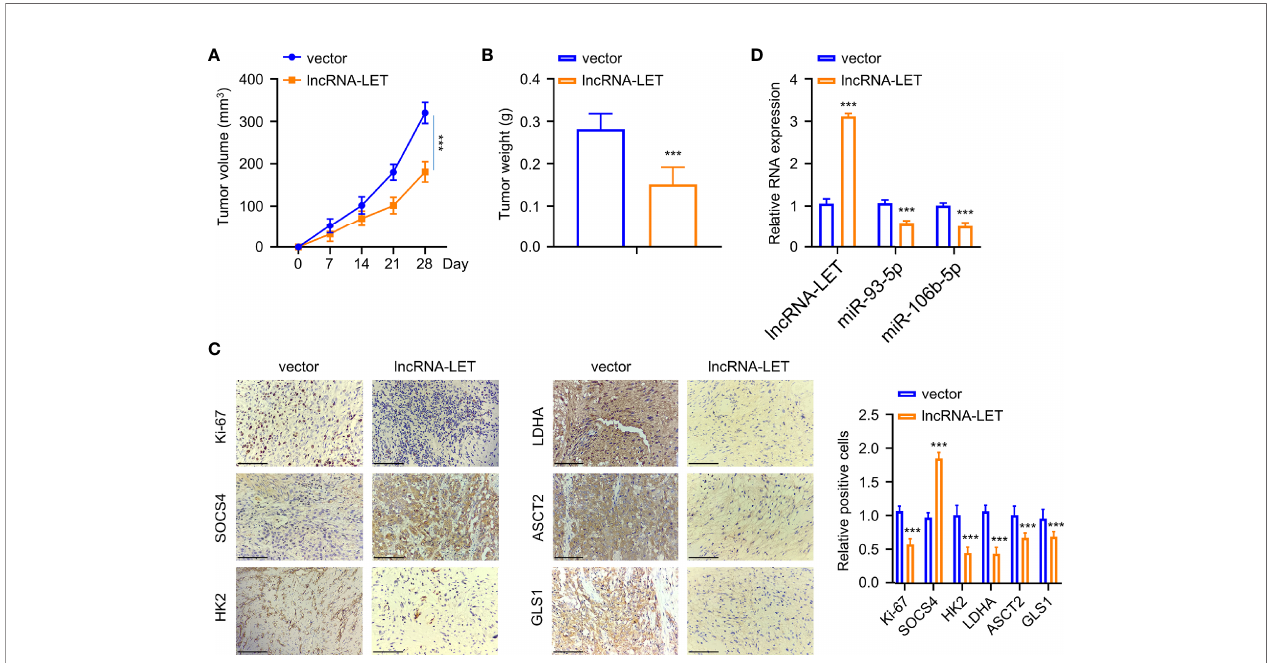
FIGURE 7 | An increase of lncRNA-LET inhibited esophageal squamous cell carcinoma cell proliferation in vivo . (A) The subcutaneous tumor volume in the tumor xenograft model. (B) The tumor weights in different groups. (C) The expression of Ki-67, SOCS4, hK2, ldhA, ASCT2, and gls1 proteins in subcutaneous tumor tissues was detected by immunohistochemistry. (D) lncRNA-LET, miR-106b-5p, and miR-93-5p expression within subcutaneous tumor tissues were detected through qRT-PCR. * P < 0.05, ** P < 0.01, and *** P <